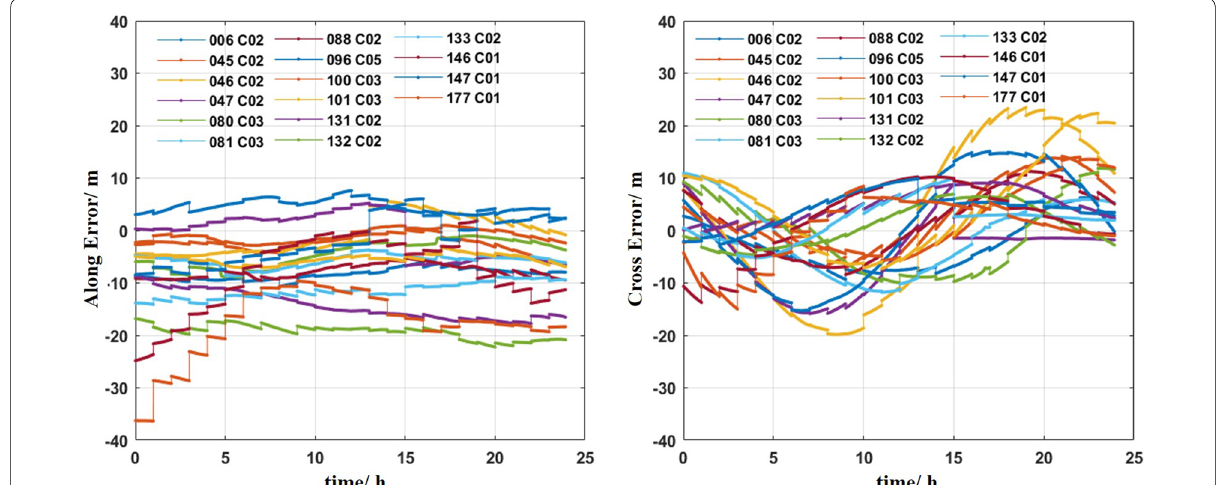
Fig. 3 Fluctuations in the along (left) and cross (right) components founded in the BDS GEO broadcast ephemeris during the first half of